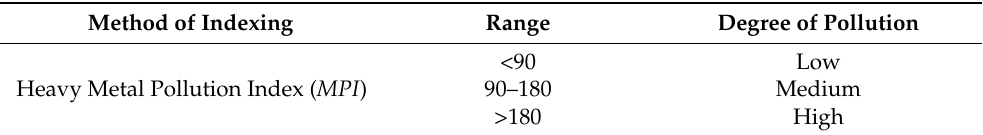
Table 1. Categorization of WQ using MPI